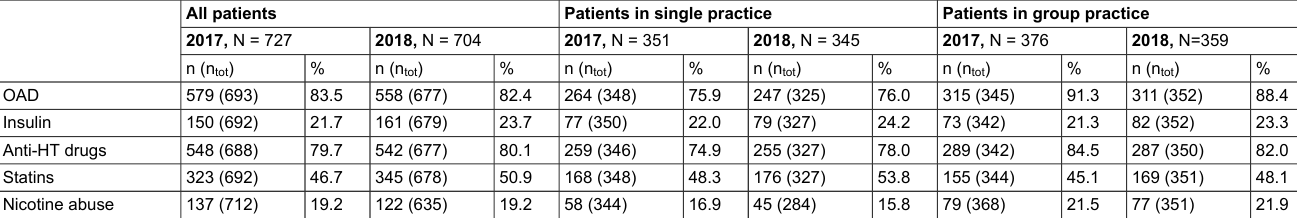
Table 3: Therapy modalities and nicotine abuse before and after the implementation of the Diabetes Score overall and stratified by practice type. All patients Patients in single